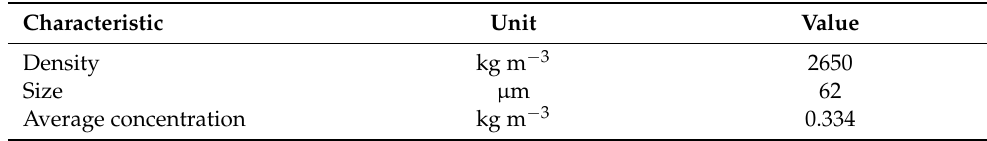
Table 4. Sediment